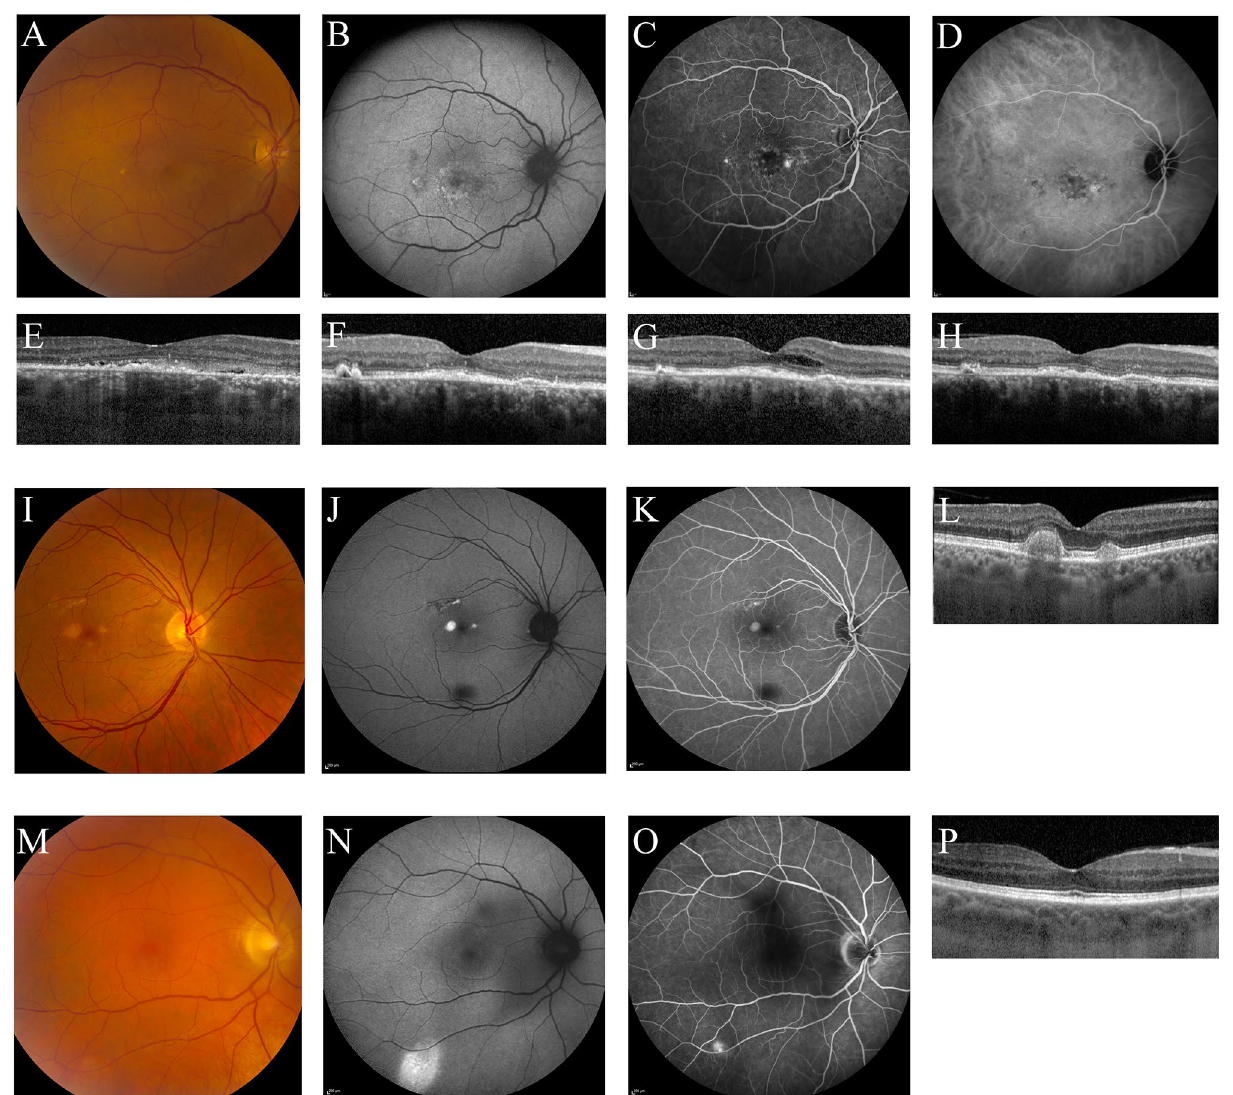
Figure 1. Multimodal imaging ( A – E ) of the right eye of a 66-year-old female patient with active Cushing’s syndrome. The optical coherence tomography (OCT) scan ( E ) revealed a small amount of subretinal fluid (SRF) with hyperreflective debris. Fundus autofluorescence ( B ) mainly showed hyperautofluorescent changes macularly. On the mid-phase fluorescein angiography ( C ) 2 ‘hot spots’ of leakage were observed, nasally and temporally to the fovea. Mid-phase indocyanine green angiography ( D ) at that time did not provide evidence for a neovascularization. In the left eye of this patient, no abnormalities were detected on multimodal imaging (not shown). As SRF persisted after 6 months of leuprorelin treatment for Cushing’s syndrome, half-dose photodynamic therapy was performed, after which the SRF almost completely resolved ( F ). However, 3 months later intraretinal fluid occurred ( G ), and intravitreal injections with bevacizumab were scheduled. After 3 initial injections once per month, a treat-and-extend protocol was used. Eight weeks after the last bevacizumab injection until to date, SRF and intraretinal fluid on OCT had disappeared ( H ). Unfortunately, visual acuity did not improve. Multimodal imaging of the right eye of a 63-year-old male with active Cushing’s syndrome ( I – M ). The foveal OCT scan ( L ) showed retinal pigment epithelium alterations and parafoveal pseudovitelliform lesions. Corresponding hyperautofluorescent abnormalities were observed on fundus autofluorescence ( J ) and mid-phase fluorescein angiography ( K ). The abnormalities observed on multimodal imaging showed to be stable during follow-up, as can be seen on the OCT scan that was obtained at the last follow-up visit at 12 months after baseline ( M ). No abnormalities were observed in the left eye of this patient (imaging not shown). Multimodal imaging ( N – Q ) of the right eye of a 61-year-old male with active Cushing’s syndrome. No abnormalities were seen on the OCT scan ( Q ). Mid-phase fluorescein angiography ( P ) showed a ‘hot spot’ of focal leakage, with an eccentric location outside the vascular arcade, and on fundus autofluorescence ( O ) hyperautofluorescent changes were observed in the same area. Unfortunately, this area was outside the covering area of the OCT scan, so possible presence of SRF could not be evaluated. No abnormalities were observed in the left eye of this patient (imaging not